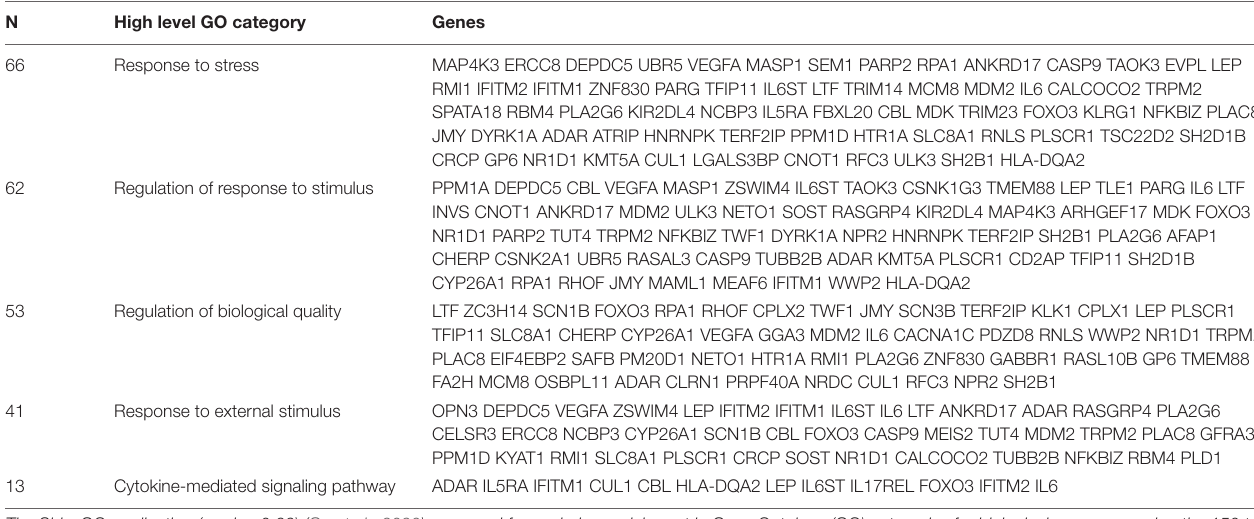
TABLE 2 | Gene Ontology biological process classification of up-regulated genes in rictor silenced PHT cells.